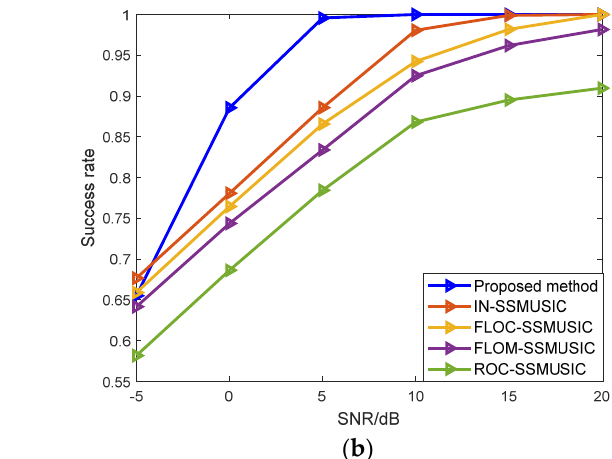
( b ) Figure 5. Analysis of the mean square error and success rate of the algorithm under noise: ( a ) Rela- tionship between RMSE and GSNR; ( b ) Relationship between success rate and GSNR. -5